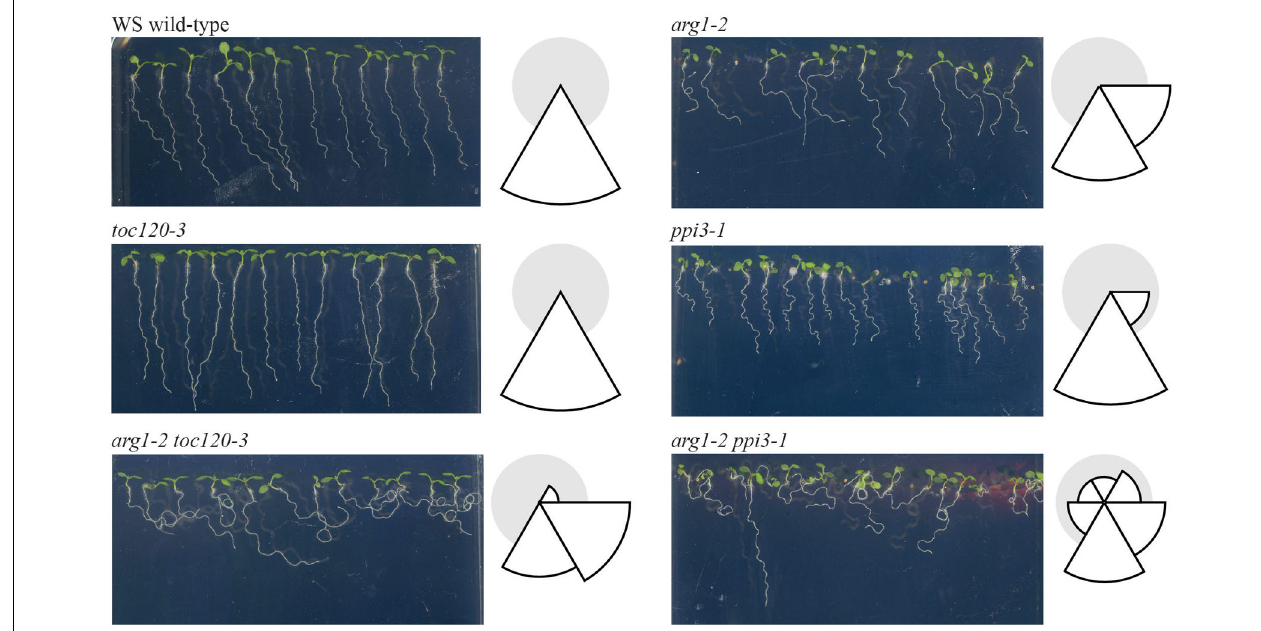
FIGURE 2 | arg1-2 toc120-3 and arg1-2 ppi3-1 seedlings showed increased variability of root growth angles compared to WS wild type and arg1-2 , toc120-3 , and ppi3-1 single mutants ( F -test, p < 0 . 05, and n = 32–44). The seedlings were grown vertically for 3 days. They were then tilted backward 30 ◦ and grown for an additional 4 days. The root angles were then measured from the root-hypocotyl